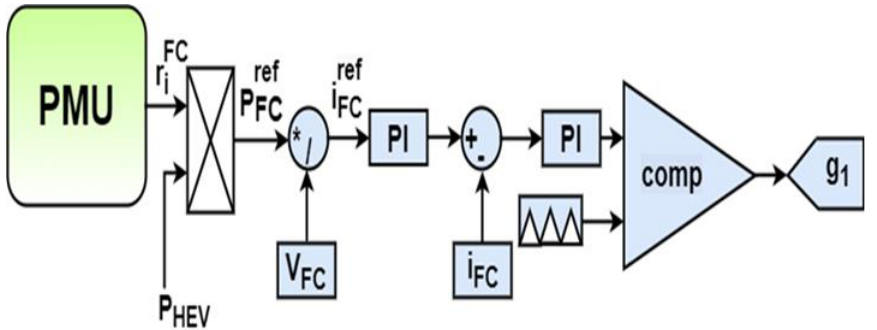
Figure 10. SC control loop.